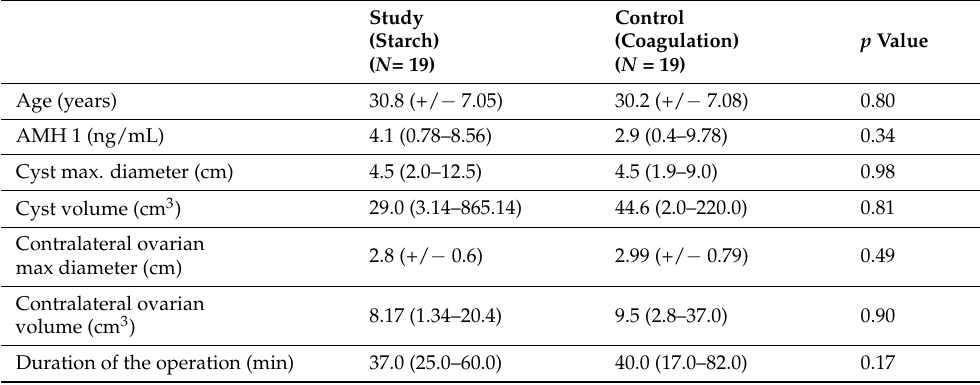
Table 1. Demographic and clinical data (mean or median and SD or